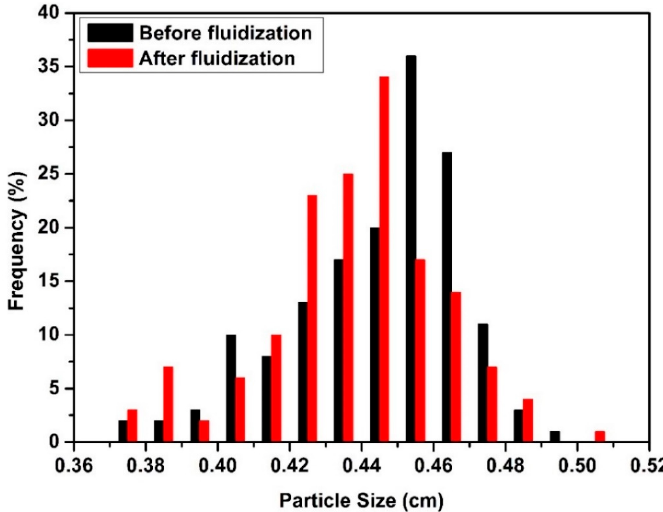
Figure 5. Particle size distribution of aerogel particles before and after Run #16. Molecules 2019 , 24 , x FOR PEER REVIEW